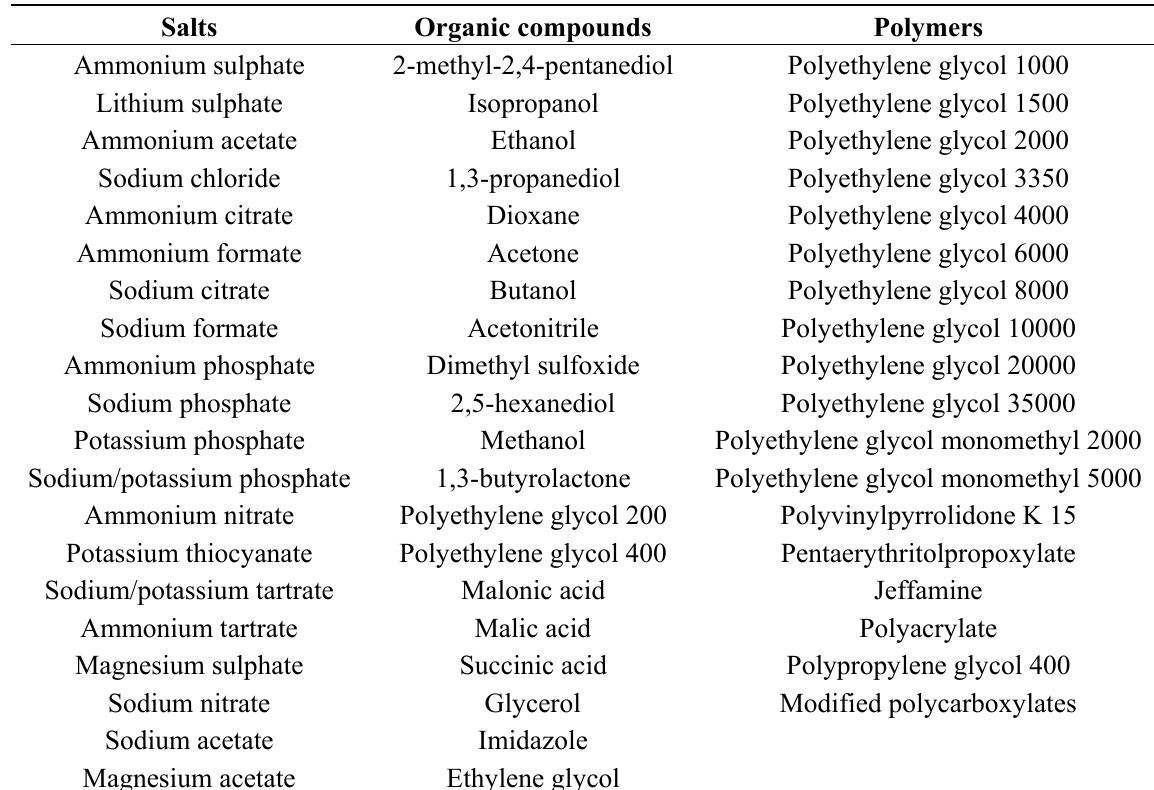
Table 2. Common precipitants used in macromolecular crystallization.